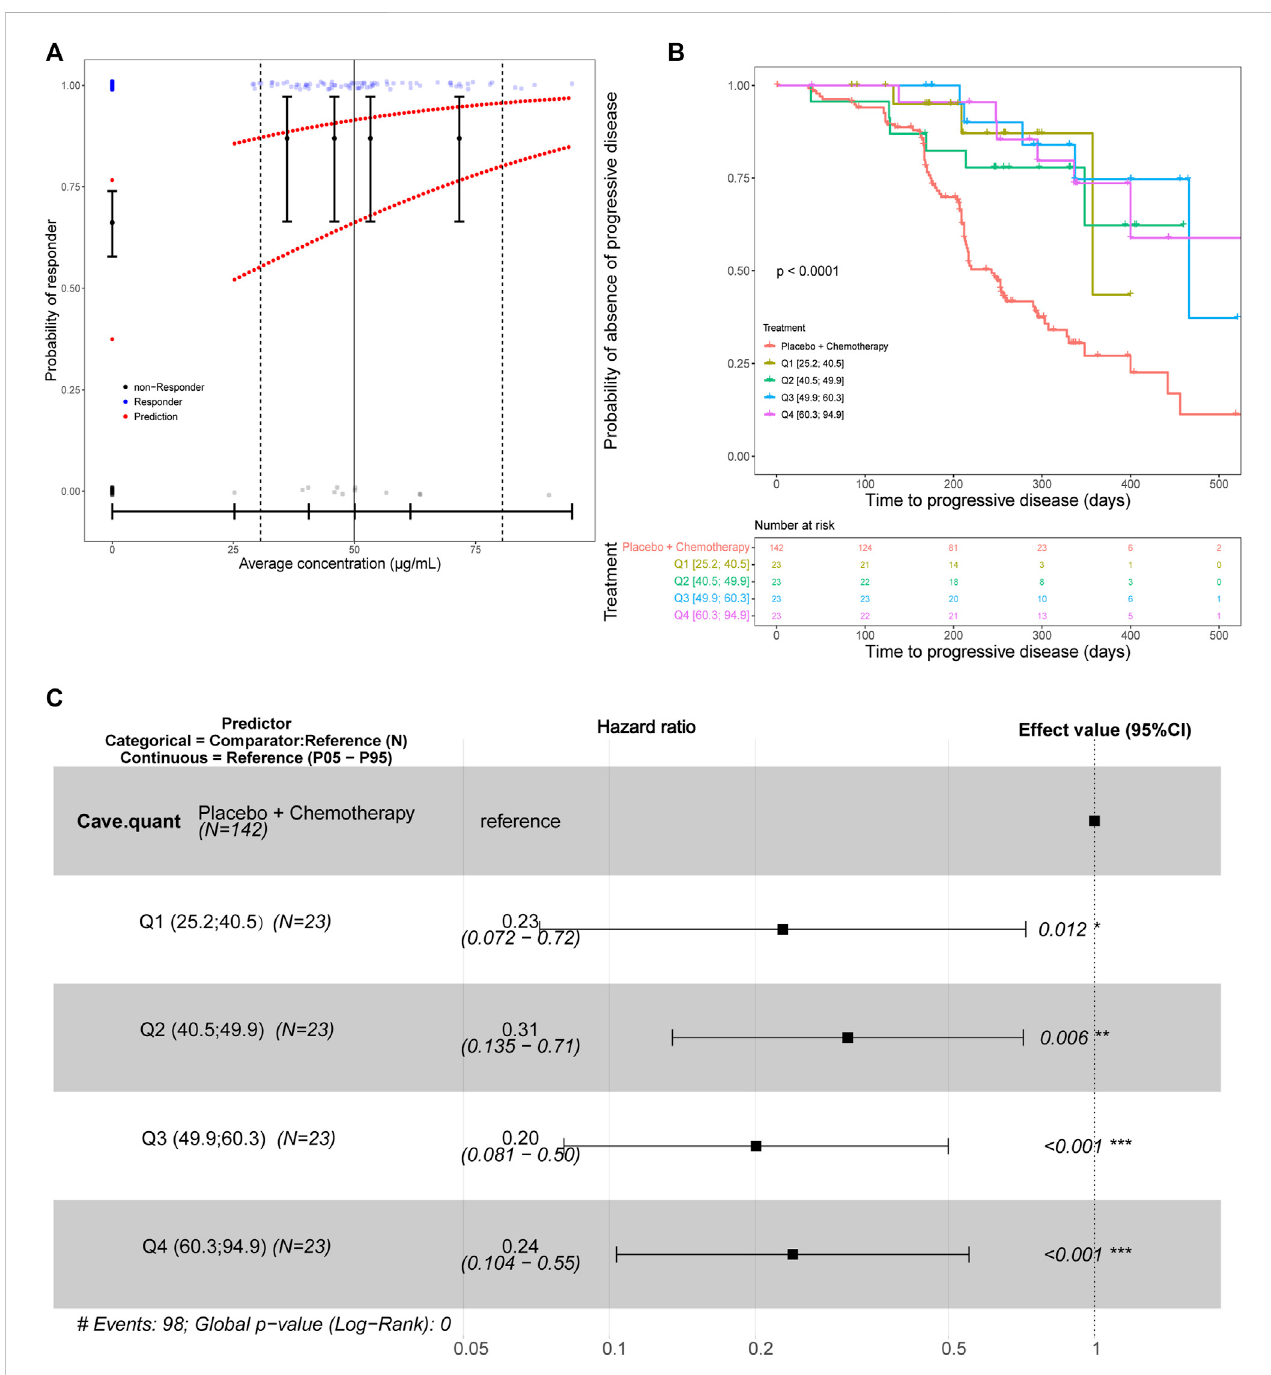
FIGURE 4 (A) Predicted probability of response for the fi nal ef fi cacy exposure-response model for the best overall response with C ave as the predictor. The black circlesintheerror barsrepresent theproportion ofpatientswhowererespondersatthemedian oftheC ave quartiles. Solid vertical blacklines intheerror bars arethe95%CIsaroundtheprobabilityofbeingaresponder.Theupperlineofreddotsistheprobabilityforatypicalpatienttobearesponder.Thelowerlineof reddotsistheprobabilityforapatientwithliverdiseaseandanECOGperformancestatusof1tobearesponder.Thesolidverticalblacklineisthemedian observed C ave . The dashed vertical black lines are the observed 5th and 95th C ave percentiles for treated patients. The small blue and gray dots are the individual observations (jittered to more easily visualize individual patients). (B) The Kaplan – Meier survival curve for progression-free survival strati fi ed by average concentration quantiles. The placebo group was considered separate from patients that received toripalimab. Therefore, the exposure quantiles are based only on the patients who received toripalimab. The number of patients at selected timepoints for each treatment group are shown in the lower panel titled “ Number at risk ” . (C) A forest plot of predictors in the progression-free survival exposure-response model with average concentration quantiles as the predictor. Abbreviations: C ave = average concentration; CI = con fi dence interval; ECOG = Eastern Cooperative Oncology Group. N = number of